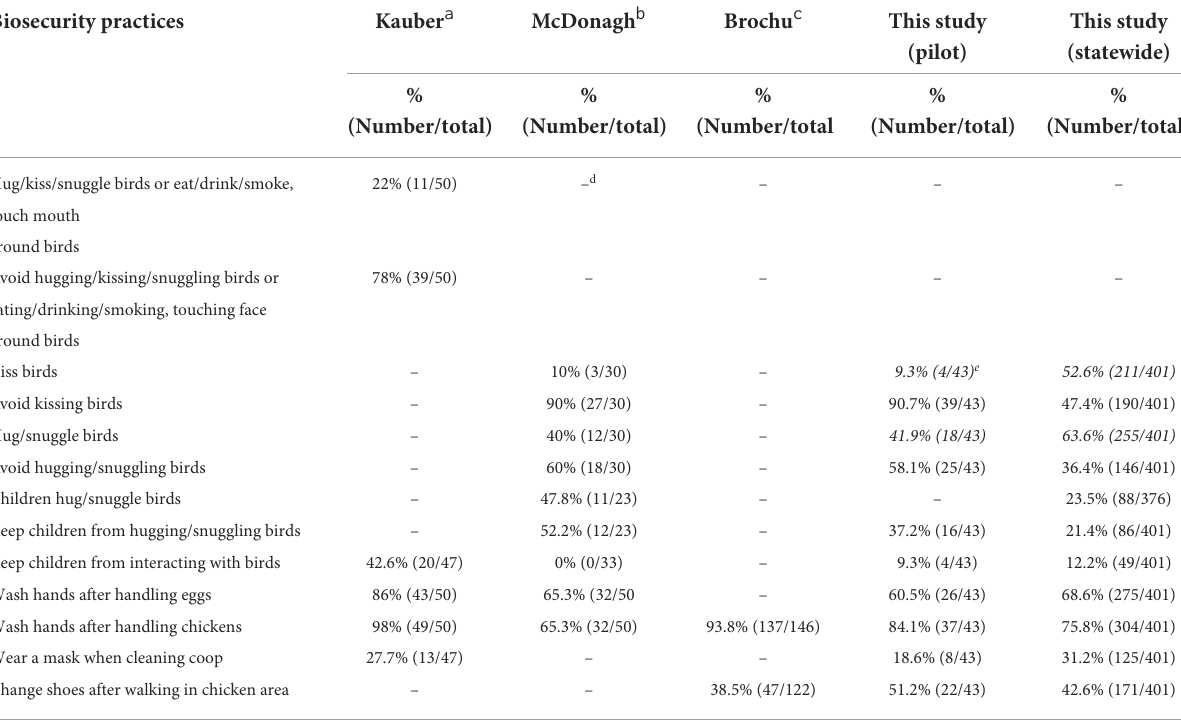
TABLE 5 Comparison of our survey data with previous